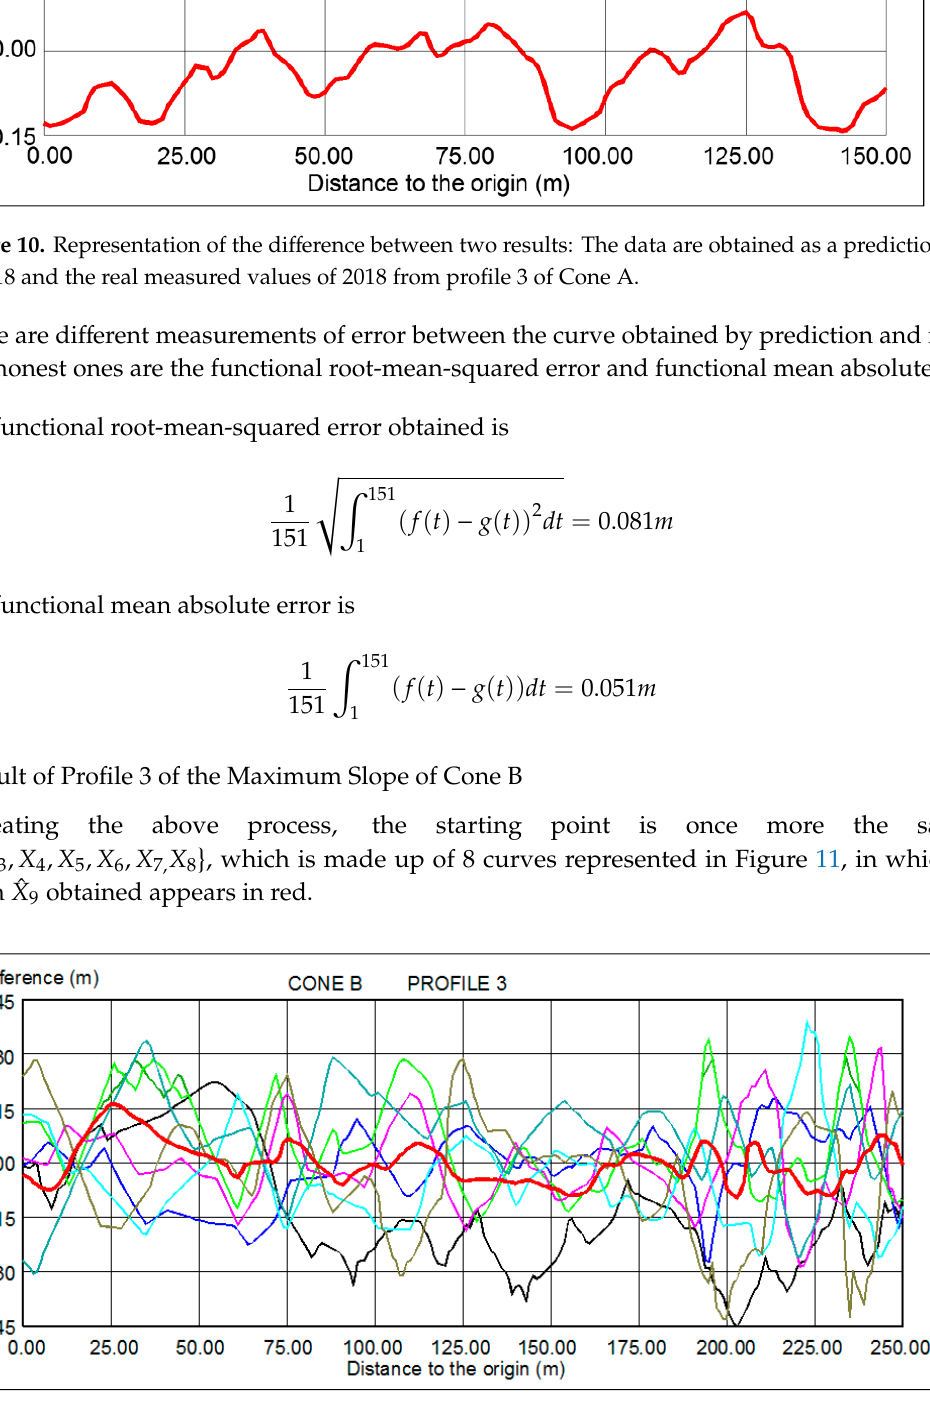
Figure 11. Predictive representation (in red) of profile 3 of Cone B. The rest of the curves belong to the space of Hilbert L 2 [ 0,1 ]